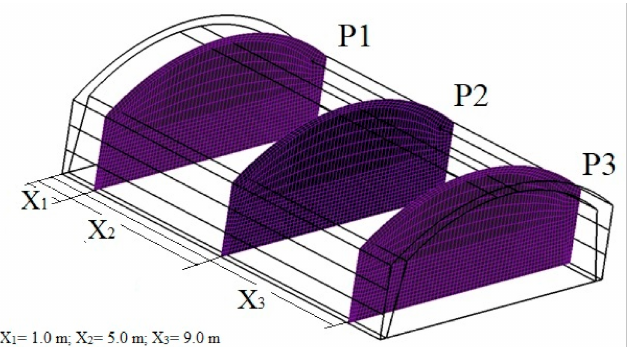
Figure 4. Geometric location of the analysis planes used for data extraction in the post-processing